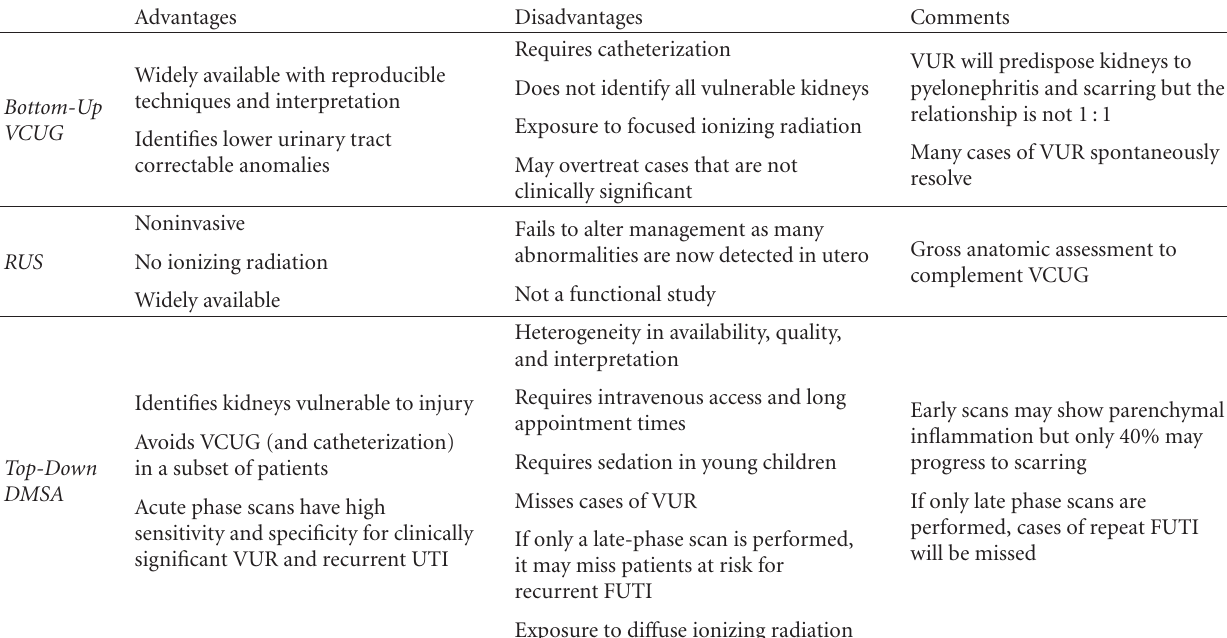
Table 1: Advantages and Disadvantages of Bottom-Up versus Top-Down